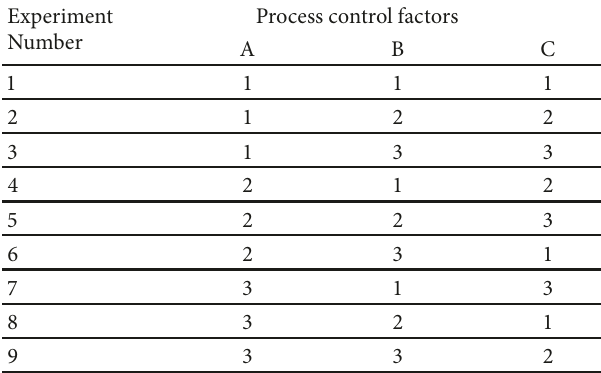
Table 1: Selected orthogonal array and